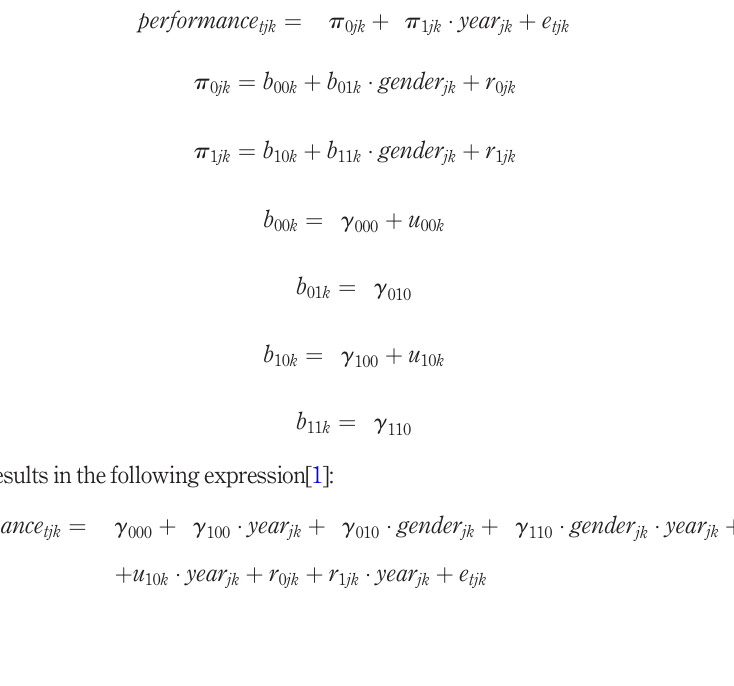
Figure 10. Likelihood-ratio